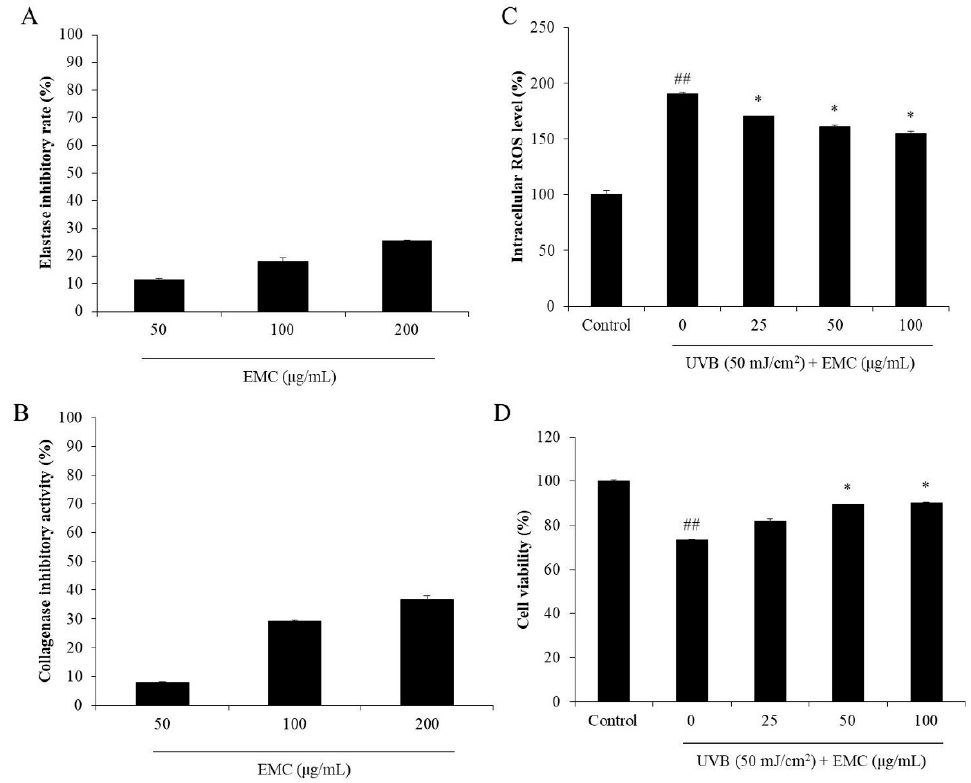
Figure 6. EMC inhibits wrinkle-related enzymes and protects human dermal fibroblasts (HDF) cells against UVB-induced damage. ( A ) Inhibitory effect of EMC on elastase; ( B ) inhibitory effect of EMC on collagenase; ( C ) intracellular ROS scavenging effect of EMC in UVB-irradiated HDF cells; ( D ) protective effect of EMC on UVB-induced cell death in HDF cells. The intracellular ROS level and cell viability of UVB-irradiated HDF cells were evaluated by DCF-DA assay and MTT assay, respectively. The experiments were conducted in triplicates, and data are expressed as the mean ± SE. * p < 0.05 as compared to the UVB-irradiated group and ## p < 0.01 as compared to the control group.